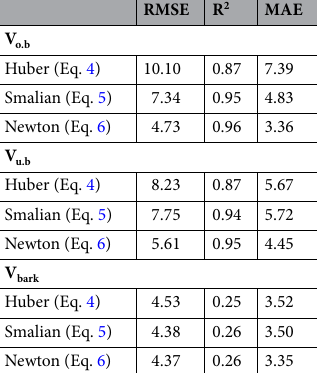
Table 2. RMSE (root mean square error), R 2 (coefficient of determination) and MAE (mean absolute error) of volume estimations with the scaling formulas Huber (Eq. 4), Smalian (Eq. 5) and Newton (Eq. 6) as input for the calculation to reference volume obtained by xylometry for the volume over bark (V o.b. ), volume under bark (V u.b. ) and bark volume (V bark ) of spruce